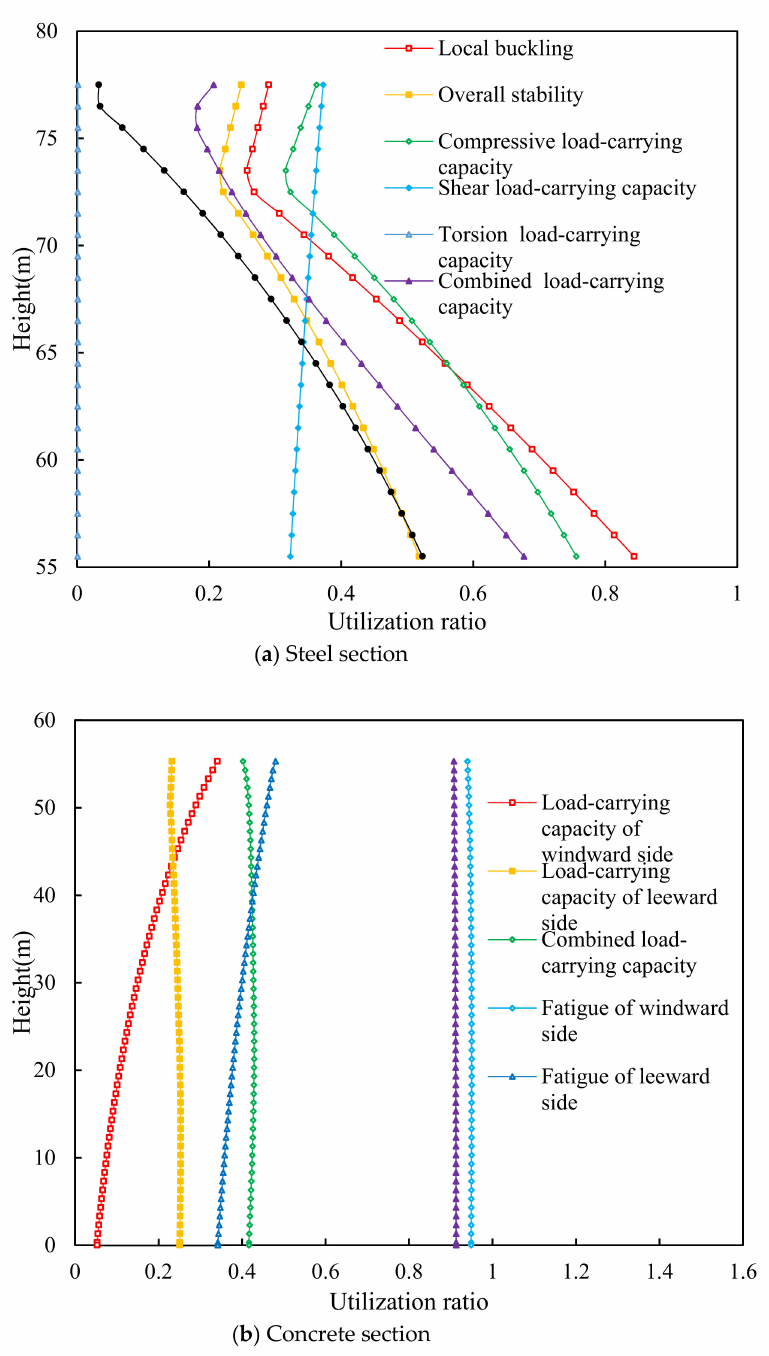
Figure 8. The utilization ratio for constraints along the